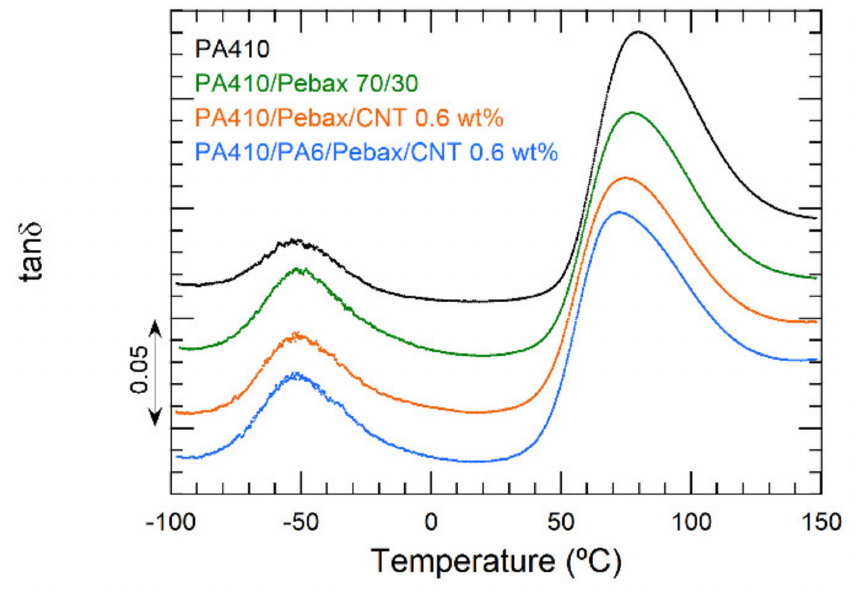
Figure 1. DMTA curves of pure PA410, PA410/Pebax 70/30 unfilled blend and, as an example, PA410/Pebax/CNT and PA410/PA6/Pebax/CNT NCs with a 0.6 wt% CNT content. Curves have been shifted in the vertical